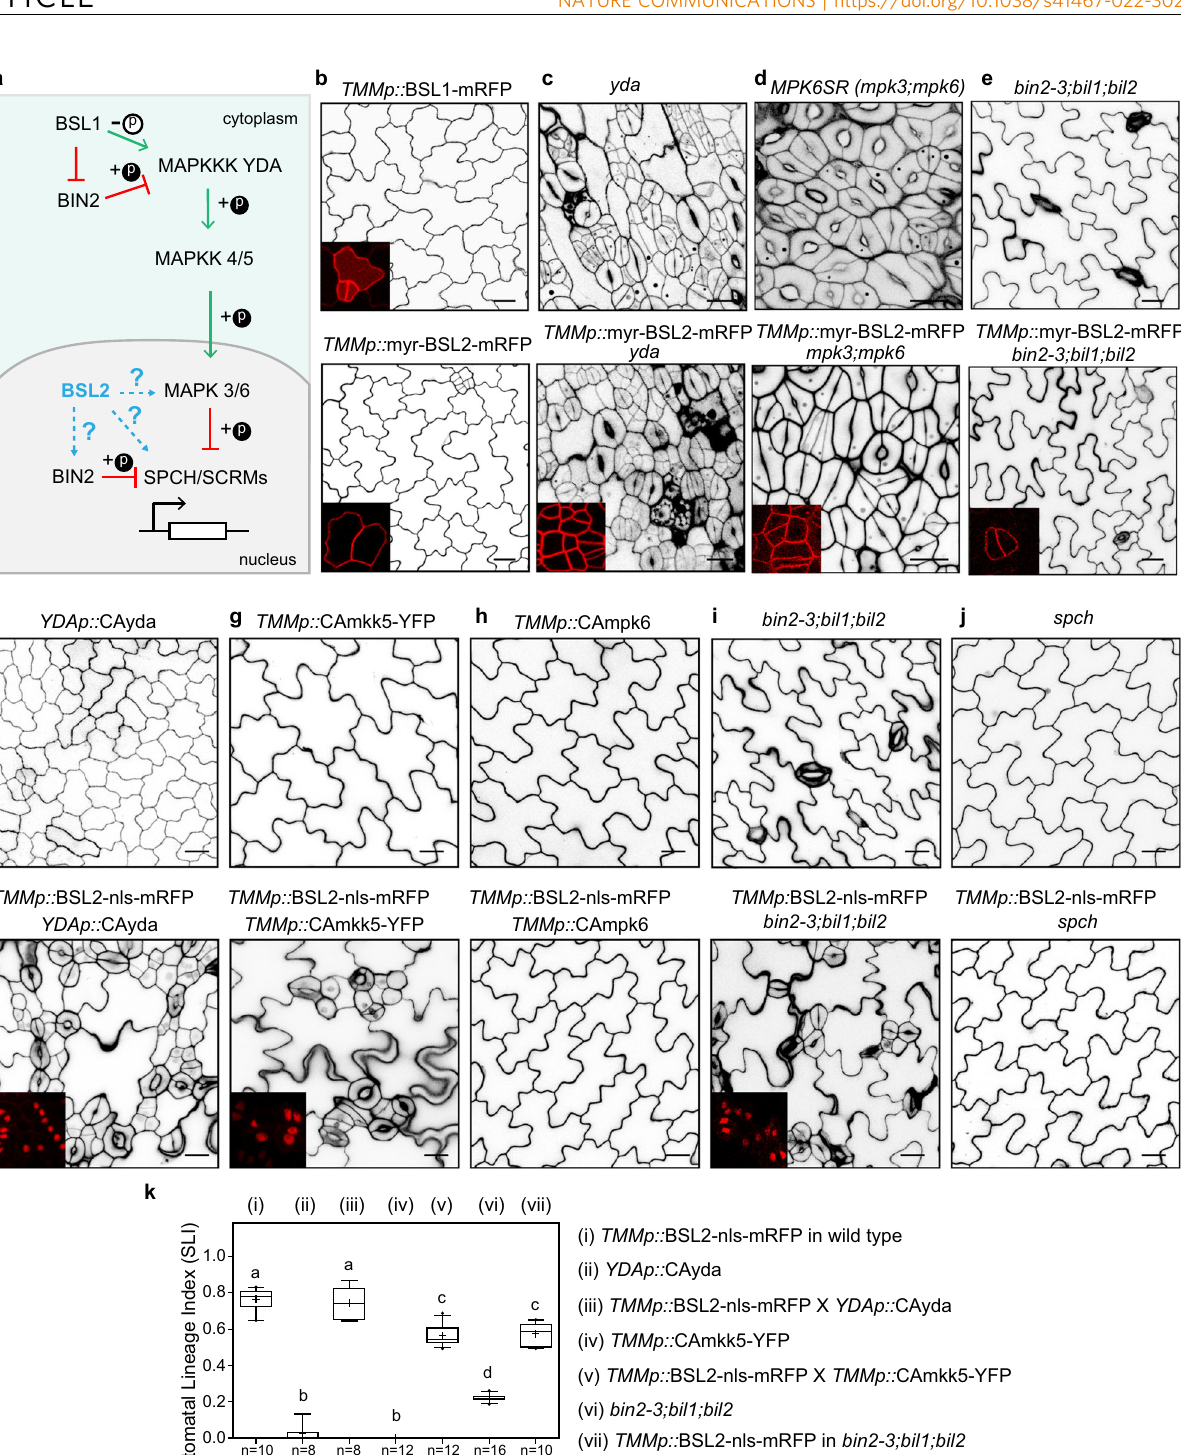
Next, we tested protein-protein interaction via the bimolecular fl uorescence complementation (BiFC) assays in leaf